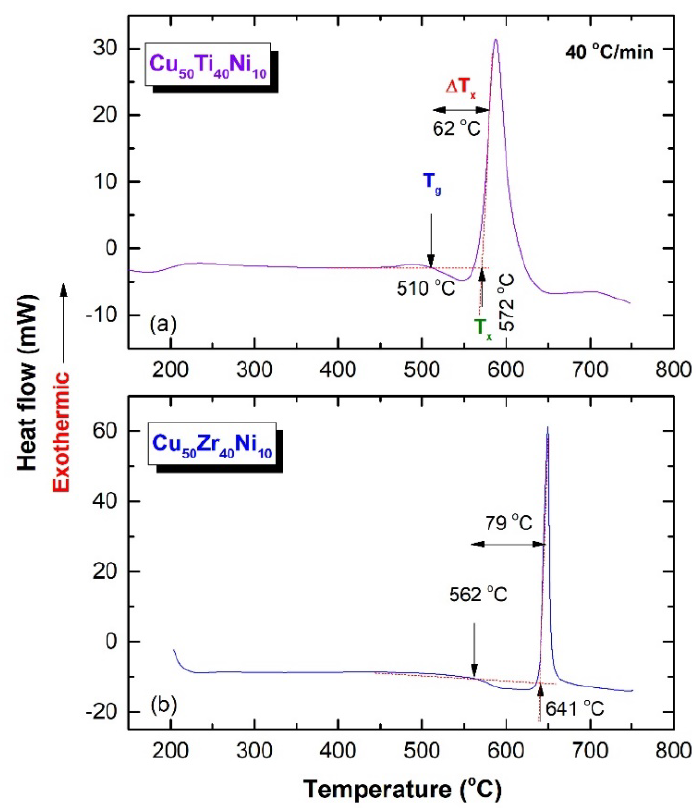
Figure 13. DSC traces conducted at 40 °C/min for ( a ) Cu 50 Ti 40 Ni 10 and ( b ) Cu 50 Zr 40 Ni 10 systems, obtained after 50 of MD time.